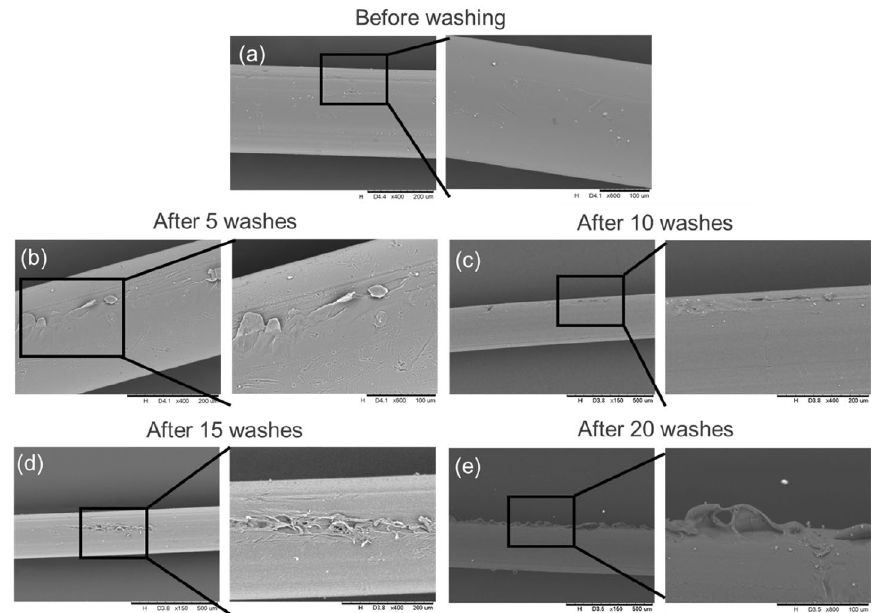
Fig. 7 SEM images of POF before and after washing: a before washing; b after 5 washes; c after 10 washes; d after 15 washes; and e after 20